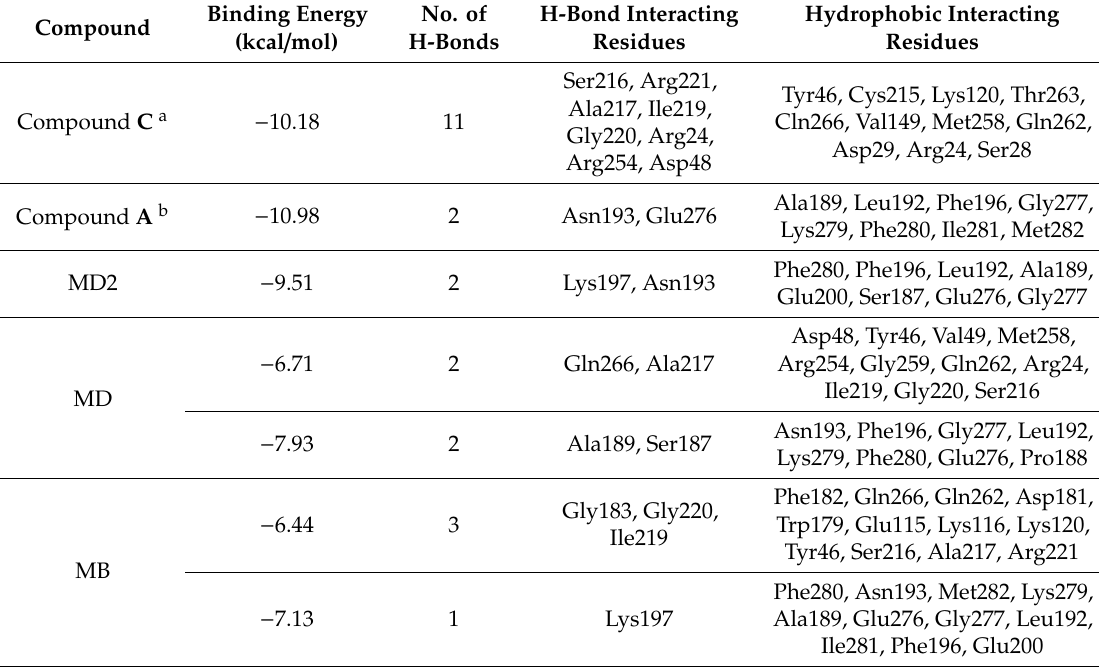
Table 2. In silico docking results of selected